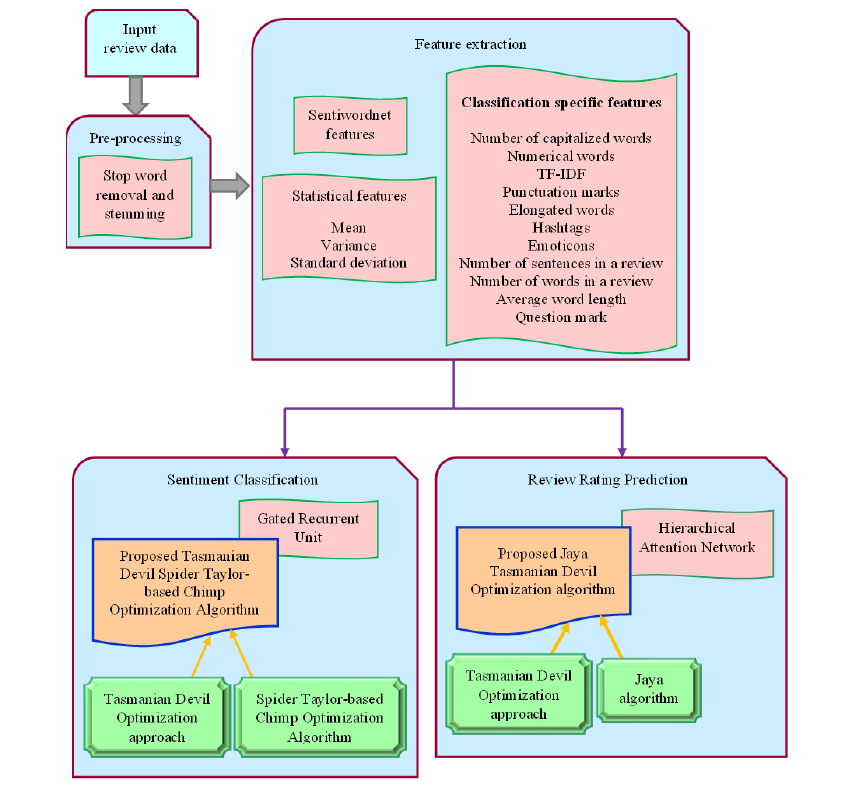
Figure 1. An illustration of proposed framework for Sentiment Classification and review rating pre-